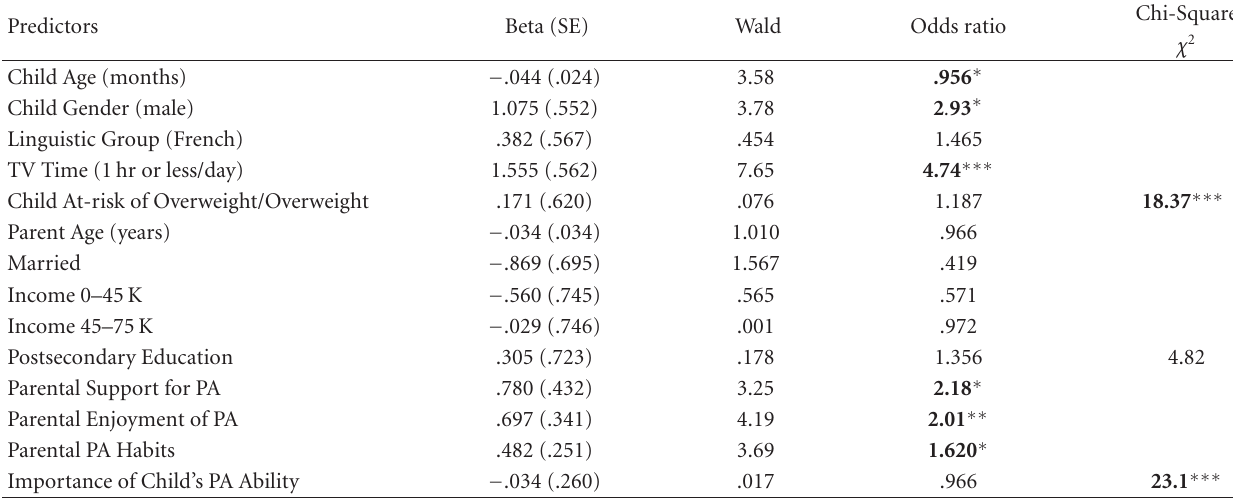
Table 1: Logistic regression predicting child daily